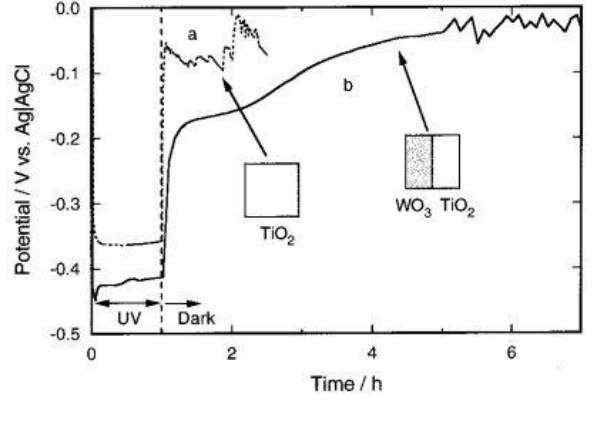
Figure 11. Changes in the potential of a type 304 stainless steel (1.75 cm 2 ) coated with TiO (a) and that coated with TiO 2 air-saturated 3 wt % NaCl solution, pH 5. TiO 1 h [22]. Reproduced with permission from the ACS, ©